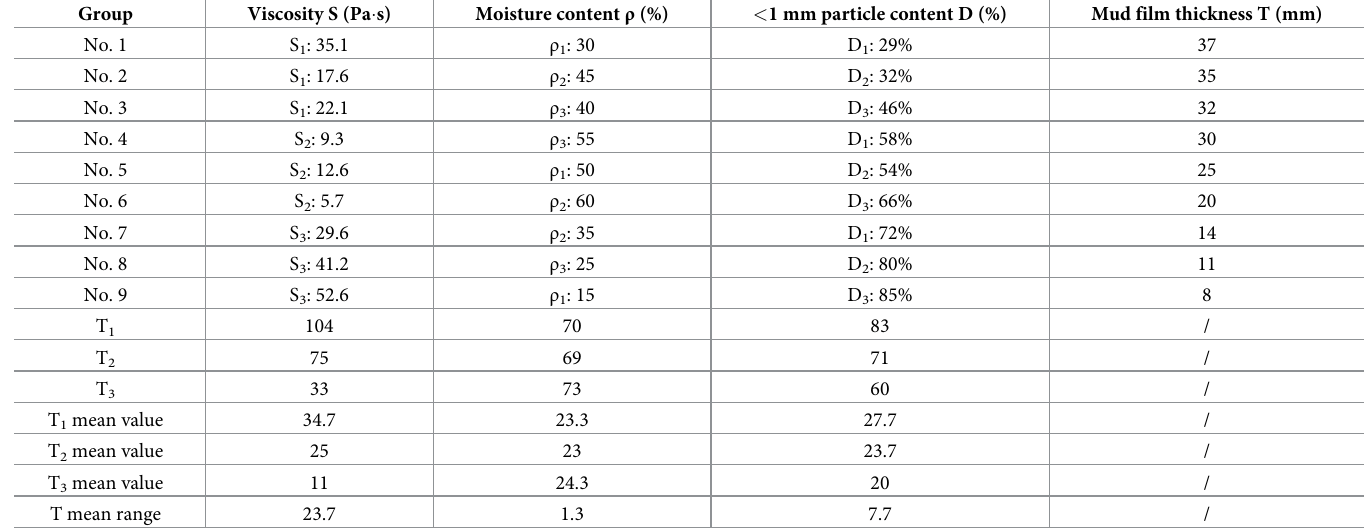
Table 4. Orthogonal test results of mud film formation from weathered red-bed